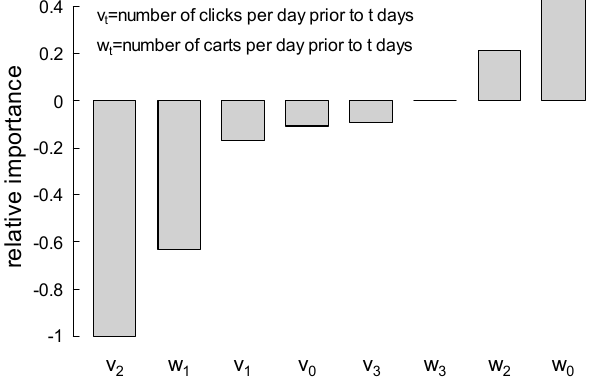
Figure 11. Relative importance of variables.